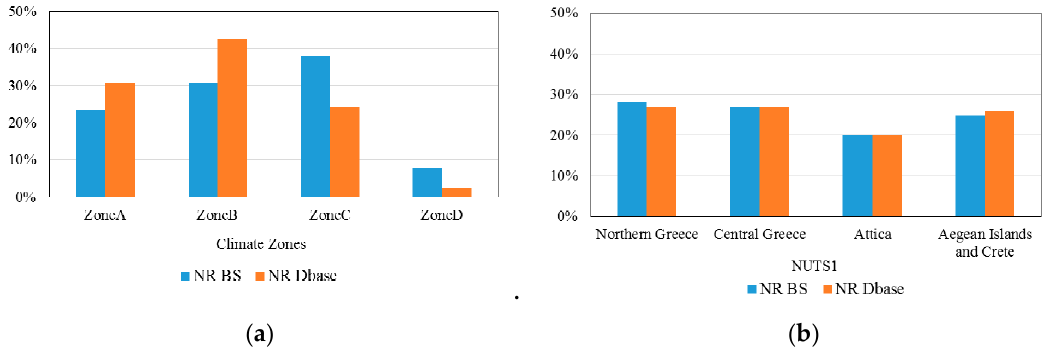
Figure 4. Spatial distribution of nonresidential buildings in the database from the certificates (NR Dbase) and the national building stock data (NR BS) ( a ) to climate zones and ( b ) to NUTS1 classification.